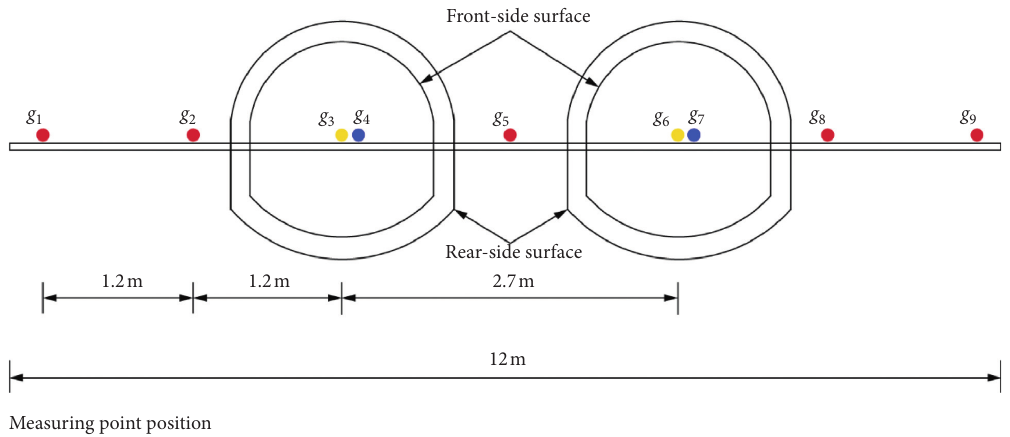
Figure 8: Positions of grating displacement sensors.